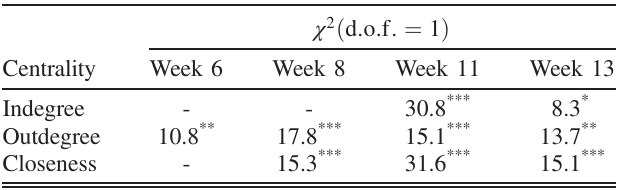
TABLE III. Summary table of the likelihood ratio test (LRT) comparing full models (final grade ∼ GPA þ centrality) to the base model (final grade ∼ GPA). Reported p values have been Bonferroni adjusted based on the total number of LRTs (i.e., scaling by a factor of nine). Significant p values are marked with the appropriate number of asterisks. Nonsignifi- cant values have been omitted for clarity. This includes the entire week